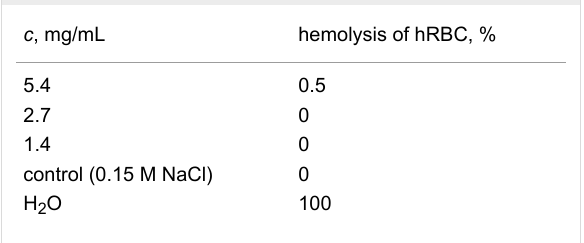
Table 1: Hemolytic activity data of 3 against human red blood cells (hRBC) in 0.15 M